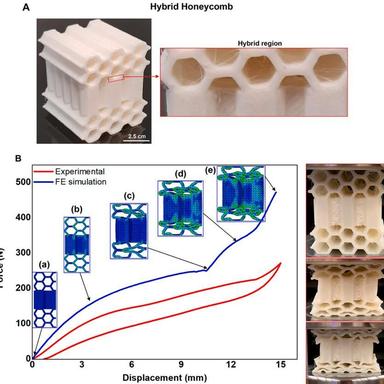
(A) 3D printed three-layer hybrid honeycomb soft lattice. In red magnification of the hybrid region, which shows how the two regions are well joined together with no visible voids. (B) Numerical and experimental forcedisplacement curves of the three-layer hybrid honeycomb lattice under compressive loading, which show: (a) initial elastic response and (b) plastic plateau of the hybrid soft lattice; (c) bending phase of cell walls; (d) stiffer configuration as the regions at the bottom and top of the structur